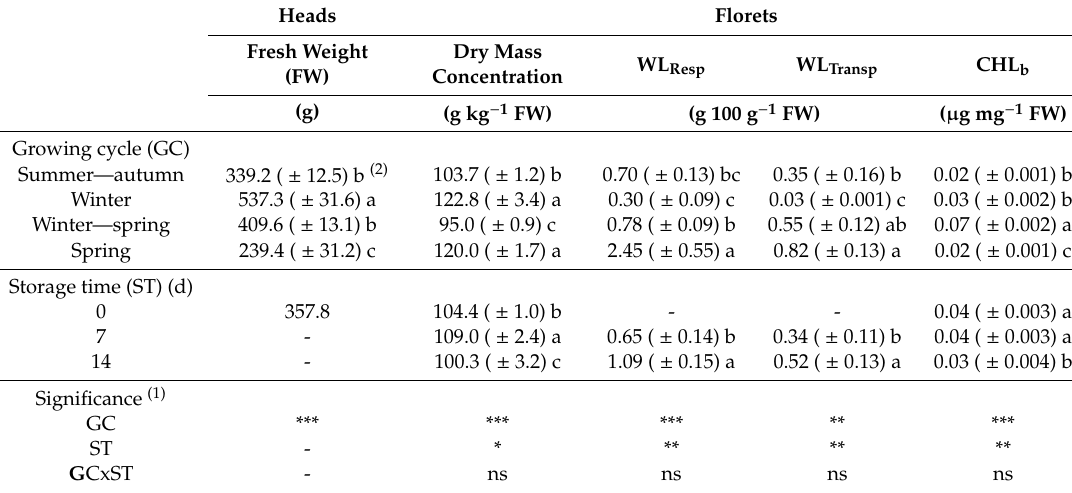
Table 2. Bio-morphological traits of raw and stored broccoli (cultivar Parthenon) as a ff ected by growing cycle and storage